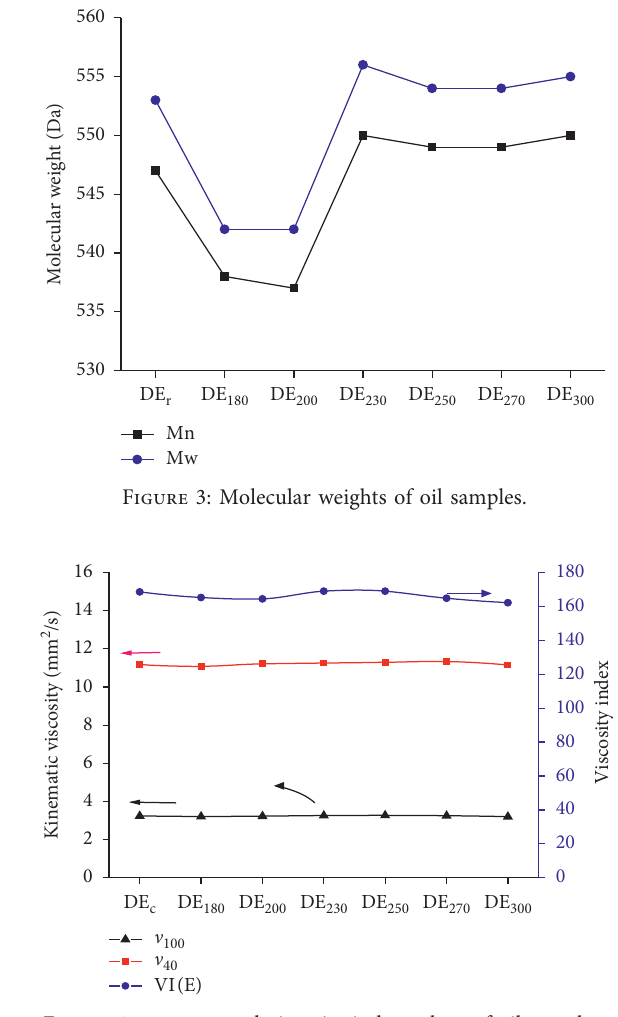
Figure 4: ] ] 40 , 100 , and viscosity index values of oil samples.